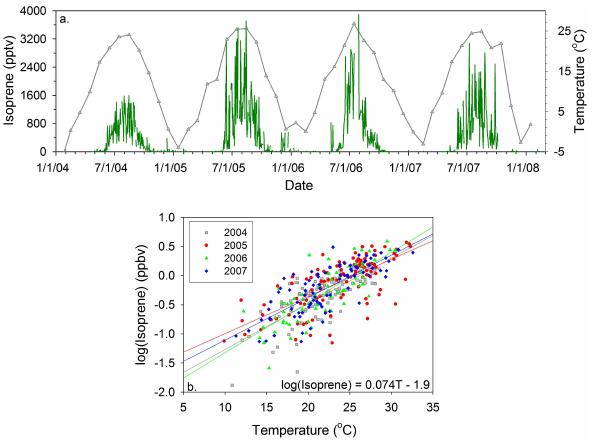
Fig. 5. Time series of (a) C 2 HCl 3 and (b) C 2 Cl 4 (pptv) at TF dur- ing January 2004–February 2008. Black line and circles are the monthly mean ± standard error mixing